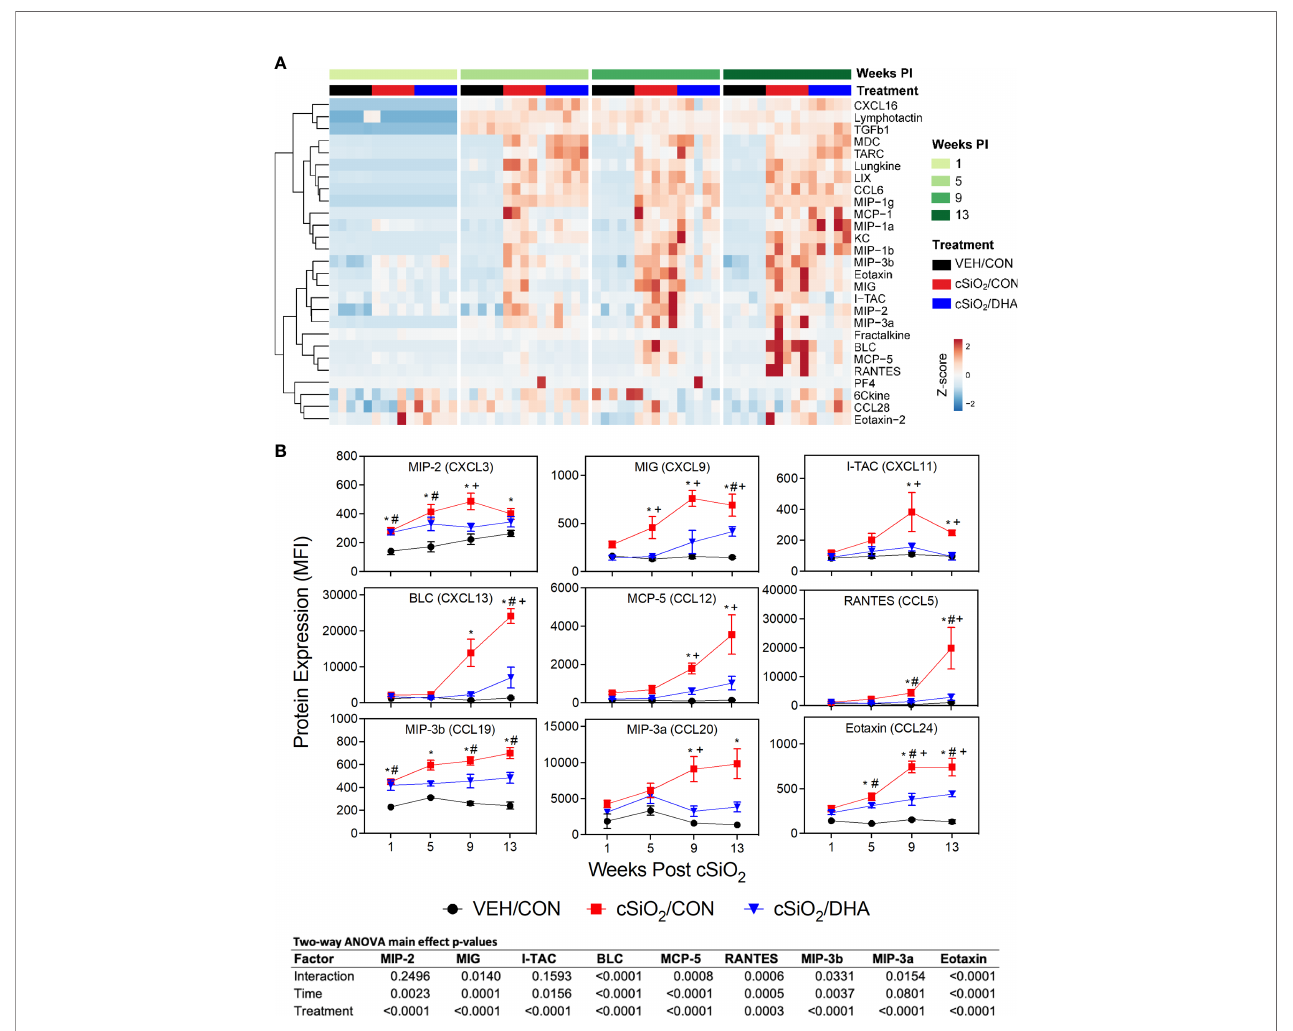
FIGURE 3 | Consumption of DHA suppresses cSiO 2 -triggered chemokine expression in BALF. (A) Heat maps with unsupervised clustering (Euclidian distance method) depict unit variance-scaled mean fl uorescent intensities (MFIs) for chemokine expression measured in the BALF. Black, red, and blue bars above the heatmap indicate the VEH/CON, cSiO 2 /CON, and cSiO 2 /DHA groups, respectively, at 1, 5, 9, or 13 wk PI. Scale bar values re fl ect the range of variance-stabilized MFIs, which were centered across rows. (B) DHA feeding suppressed selected cSiO 2 -induced chemokines in BALF over time. MFIs were obtained using the microarray panel for VEH- or cSiO 2 -exposed mice fed CON or DHA diet. Data for select proteins were analyzed by two-way ANOVA for main effects of timepoint and treatment with post-hoc Tukey HSD multiple comparison tests to determine effects of treatment at each time point. Data are mean±SEM. Main effect p-values for timepoint, treatment, and the interaction of these factors are shown below the plots. Symbols indicate signi fi cant differences (p ≤ 0.05) as follows: * for cSiO 2 /CON vs. VEH/CON; # for cSiO 2 /DHA vs. VEH/CON; and + for cSiO 2 /CON vs. cSiO 2